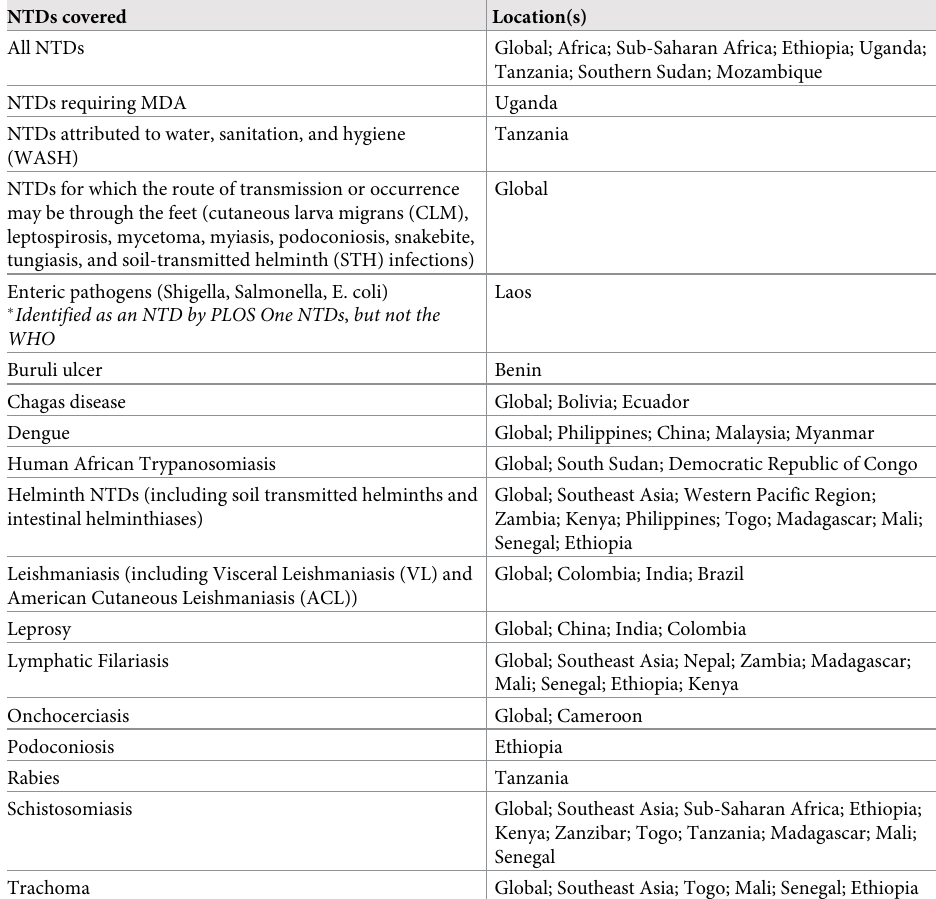
Table 1. NTDs covered and their